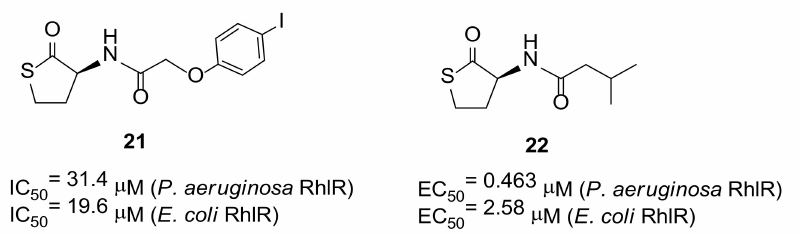
Figure 7. Thiolactone-based modulators targeting QS RhlR receptors from the Blackwell’s group. Building on their previous investigations on QS modulators, Suga’s group [42] synthe- sized and evaluated a series of AHL analogues in which the lactone is changed to various scaffolds. Several heterocyclic examples are included in this work, either with non-aromatic ones discussed below, and aromatic ones discussed in the next section. For their solid support synthesis, diethyl malonate was used as a nucleophile, which was coupled with an acyl chloride to generate the 3-oxo-propanoate moiety. After oxidation and attachment to a DHP resin, the ethyl ester was treated with LiOH to provide the acid which involved in a coupling reaction with various amines. The attached amide was then treated with TFA to be released as the final product with a hydroxyl group at the terminus of the acyl chain (Scheme 3). The thiolactone 23 , the lactam 24 and the piperidine derivative 25 were found agonists whereas the pyrrolidine derivative 26 was found to exert antagonistic activity. The amino-isoxazolidinone derivative 27 and the lactone 28 exert no agonistic activity. Sintim and coworkers [43] revealed that oxazolidinone-based AHL analogue 29 was a very potent agonist which induced bioluminescence with remarkably similar intensities to the native ligand (3-oxo-C12 HSL) in the reporter strain E. coli pSB1075 containing QS-regulated bioluminescence genes. In another biological assay, the authors found that compounds 29 and 30 responded to the CviR QS system in C. violaceum CV026. Com- pound 30 was able to act as an agonist to activate the violacein production whereas compound 29 could inhibit this phenotype in high concentration. Regarding their synthe- sis, 3-aminooxazolidinones were prepared from the reaction of dimethyl carbonate with 2-hydrazinoethanol. Followed acylation with acyl chlorides gave the final oxazolidinone- based AHL analogues (Scheme